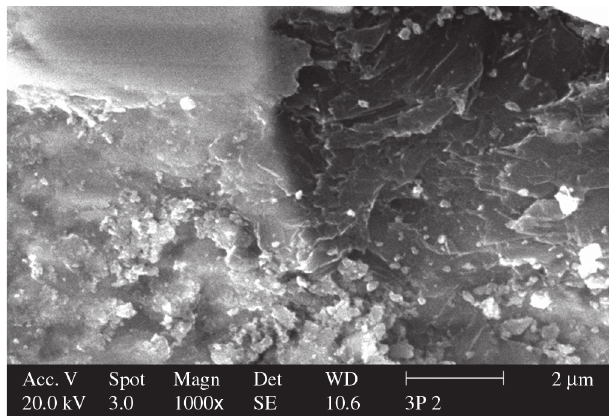
Figure 6. Removal of graphite from its nest; SEM image, SE mode.